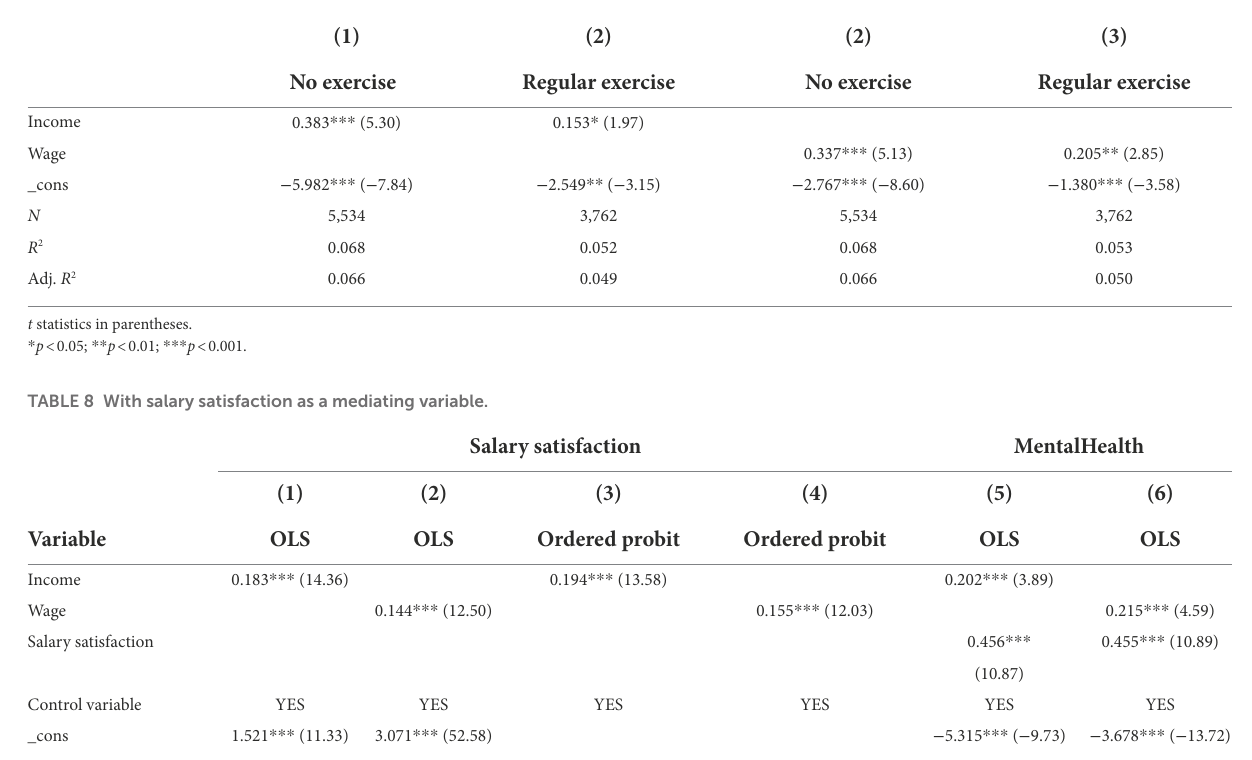
TABLE 7 Heterogeneous effects of different exercise frequencies on income.